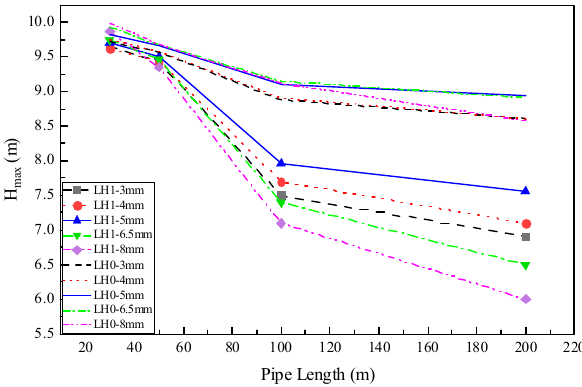
Figure 10. Average initial limit lift and restart limit lift change.